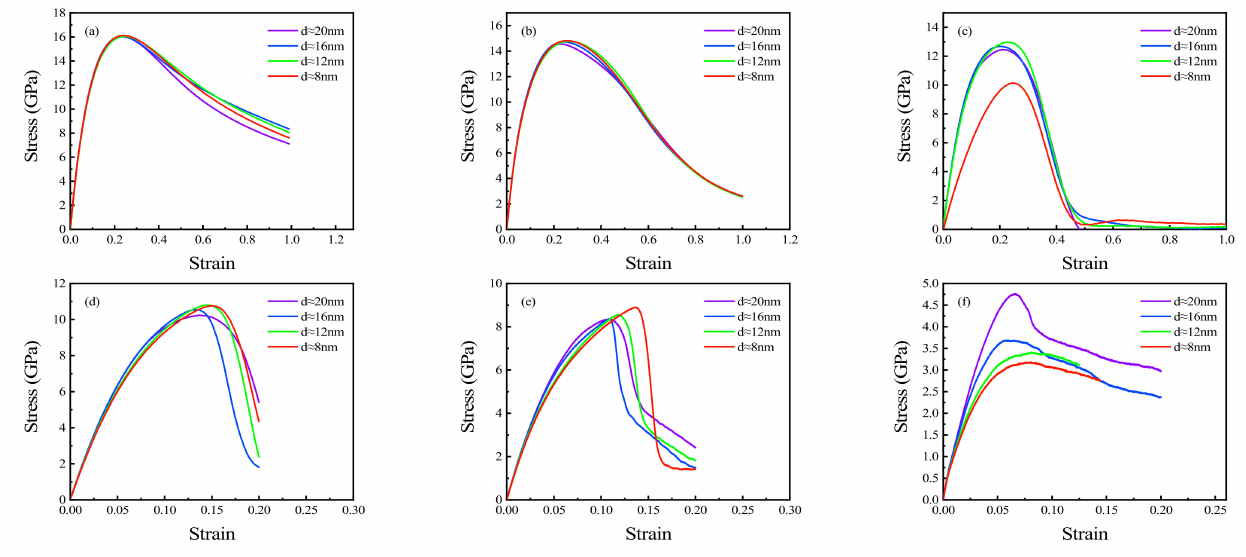
Figure 4. Stress-strain response of polycrystalline Cu 6 Sn 5 at strain rates of ( a ) 10 ps − 1 , ( b ) 1 ps − 1 , ( c ) 0.1 ps − 1 , ( d ) 0.01 ps − 1 , ( e ) 0.001 ps − 1 , and ( f ) 0.0001 ps − 1